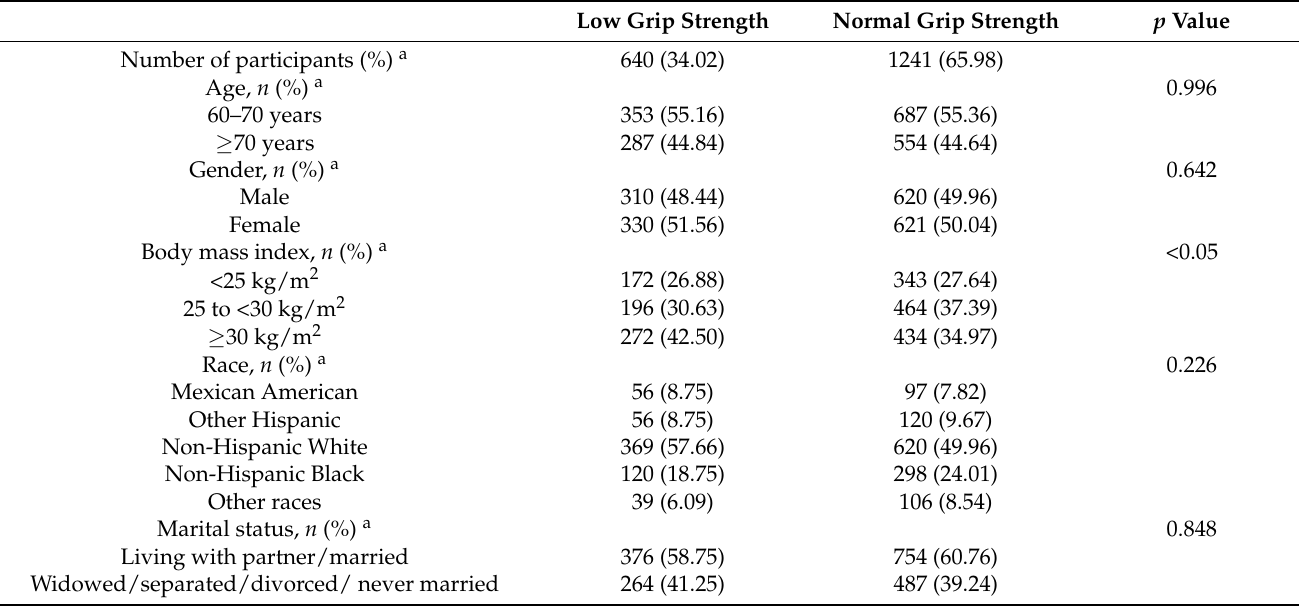
Table 1. Baseline characteristics of participants, NHANES 2011–2014 ( n =